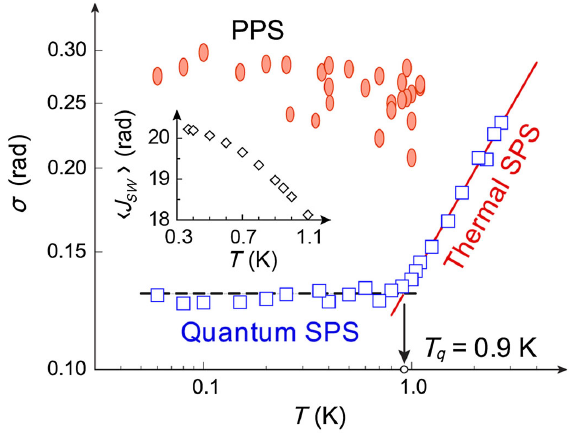
FIG. 5. Temperature dependence of standard deviations of SPS and PPS switching current distributions. The temperature T q (black arrow) marks a crossover from thermal activation to quantum tunneling of SPS. The solid red line is the best fit of σ T Þ in the thermally activated regime: σ T > T q Þ ¼ SPS ð SPS ð 0 . 136 T 0 . 54 rad. The dashed black line shows the best fit in the T < T 0 . 130 rad. In the quantum tunneling regime: σ q Þ ¼ PPS ð T Þ , inset, the average switching current versus temperature, J sw ð is shown. The switching current continues to increase with cooling down to temperatures much lower than T q